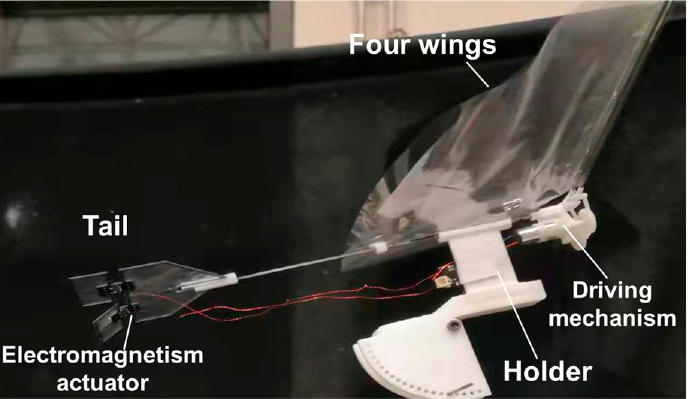
Figure 1. Reference experimental setup.